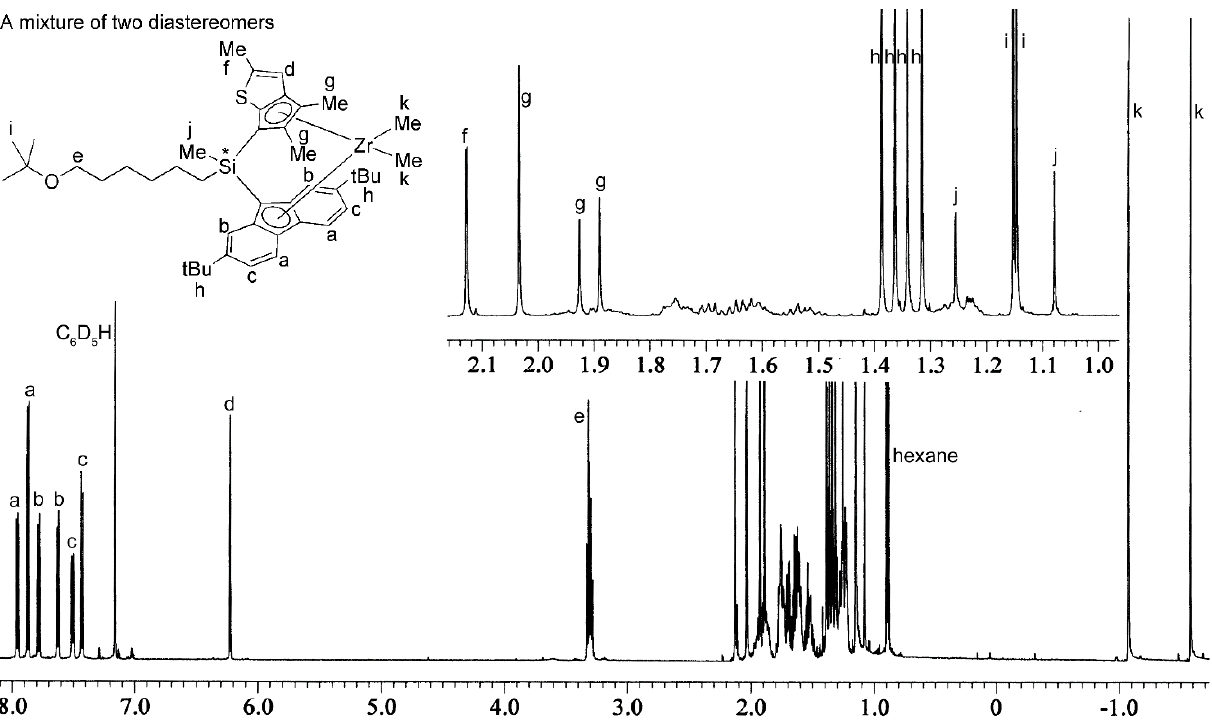
Figure 2. 1 H NMR spectrum of 20 (asterisk for chiral center)